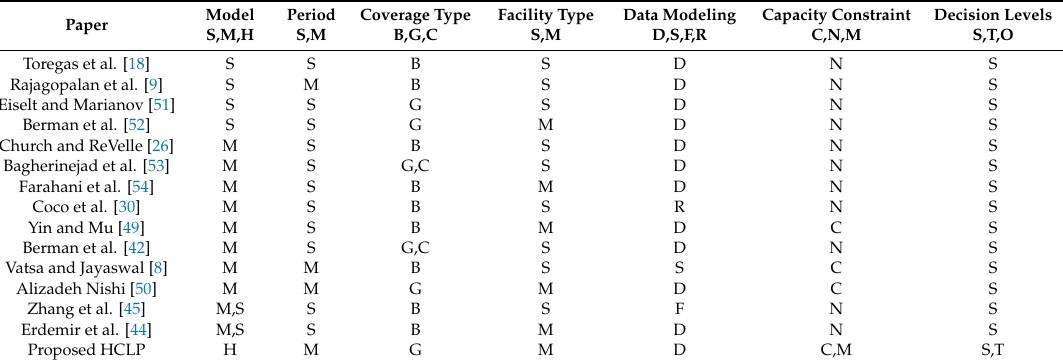
Table 1. Related papers in the literature (classified based on modeling